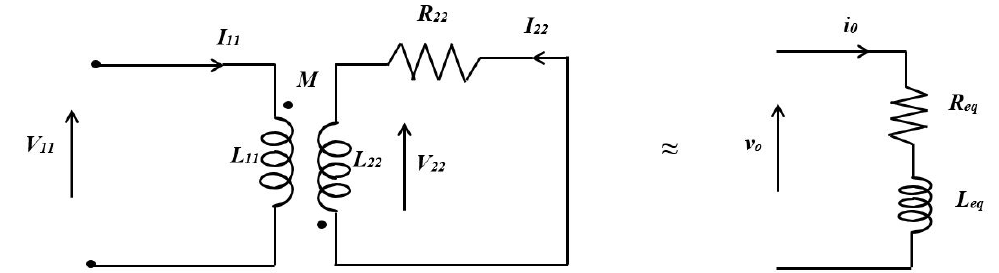
Figure 9. Electrical equivalent load model of the IH